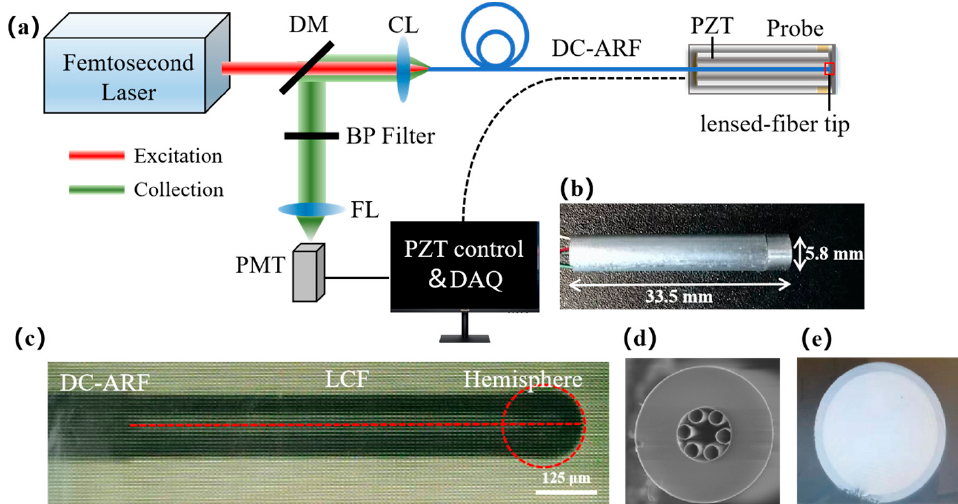
Figure 1. ( a ) Schematic of objective-lens-free fi ber-optic TPEM. DM: dichroic mirror. CL: coupling lens. DC-ARF: double-cladding antiresonant fi ber. PZT: piezoelectric ceramic tube. BP fi lter: band- pass fi lter. FL: focusing lens. PMT: photomultiplier tube. ( b ) Photograph of the 1.6 g integrated